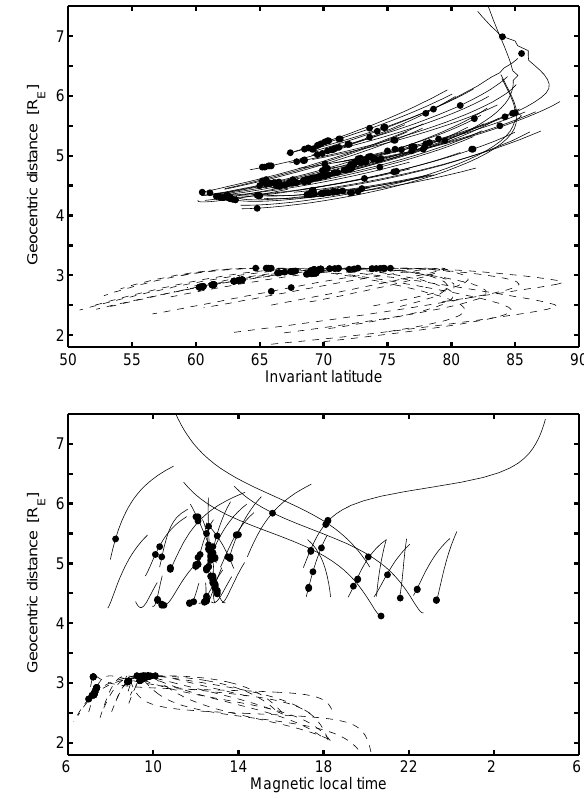
Fig. 7. The geocentric distance as a function of invariant latitude (upper panel) and MLT (lower panel) for the investigated data inter- vals for Cluster (the solid lines) and for Viking (the dashed lines). The dots mark the locations of the identified LHCs. There are in total 701 identified LHCs, so many of the dots